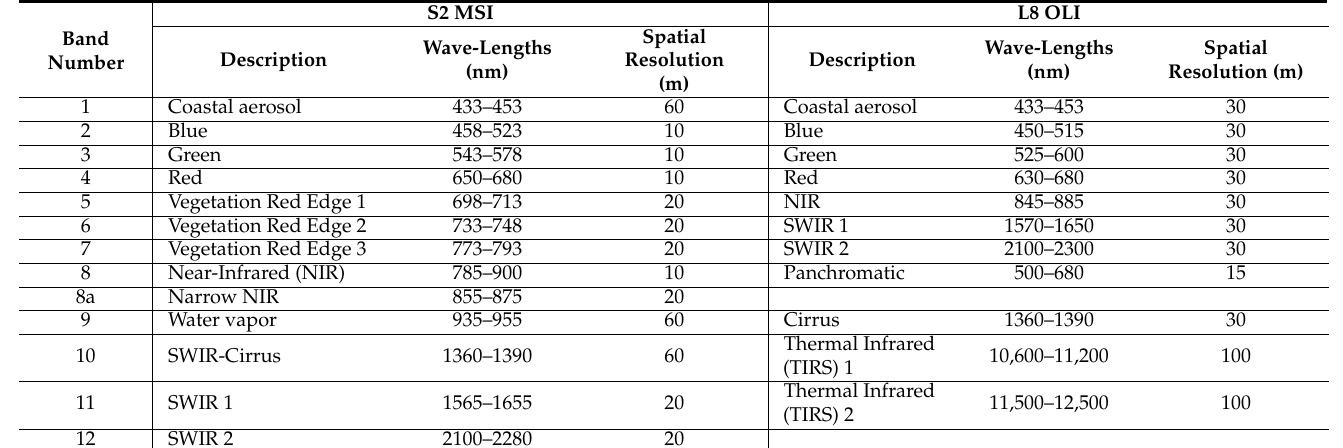
Table 2. Specifications of spectral bands for S2 MSI [25] and L8 OLI